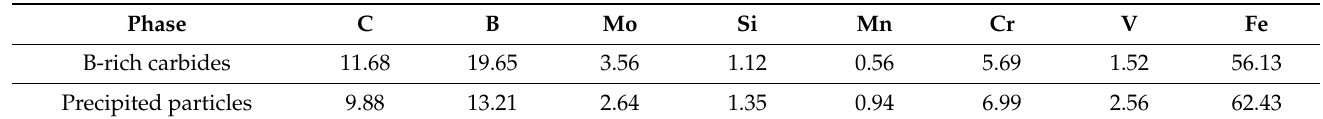
Figure 10. Bright-field TEM micrographs and corresponding selected area diffraction patterns (SADPs) of B-rich carbide and precipitated particles: ( a ) bright-field TEM micrographs and SADPs of B-rich carbide; ( b ) bright-field TEM micrographs and SADPs of precipitated particles; ( c ) HR-TEM image of precipitated particles. Table 3. EDX test results of TEM samples (at%).